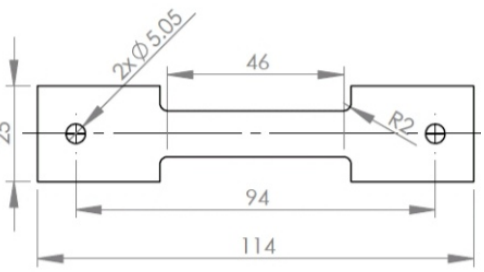
Figure 2. Hot uniaxial tensile test specimen (all dimensions are in